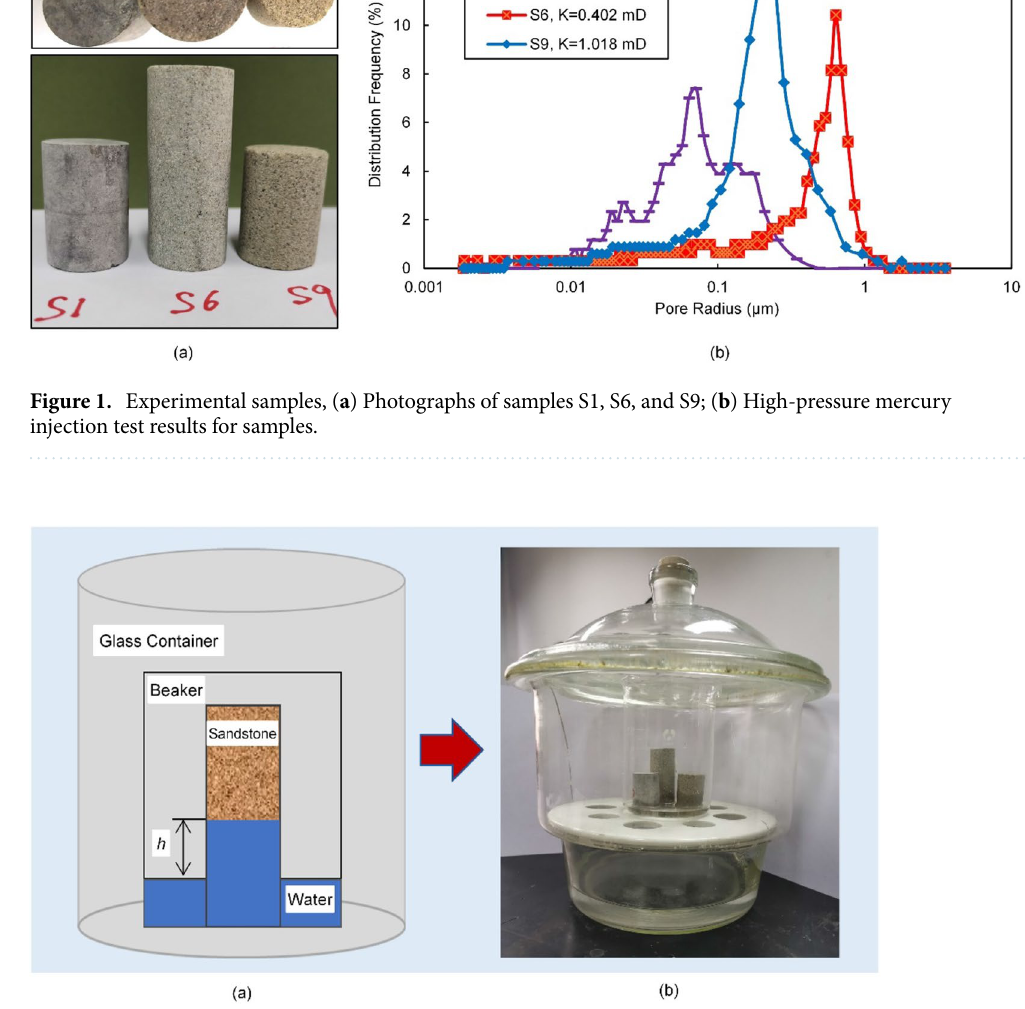
Figure 2. Schematic diagram and device picture for gas–water imbibition